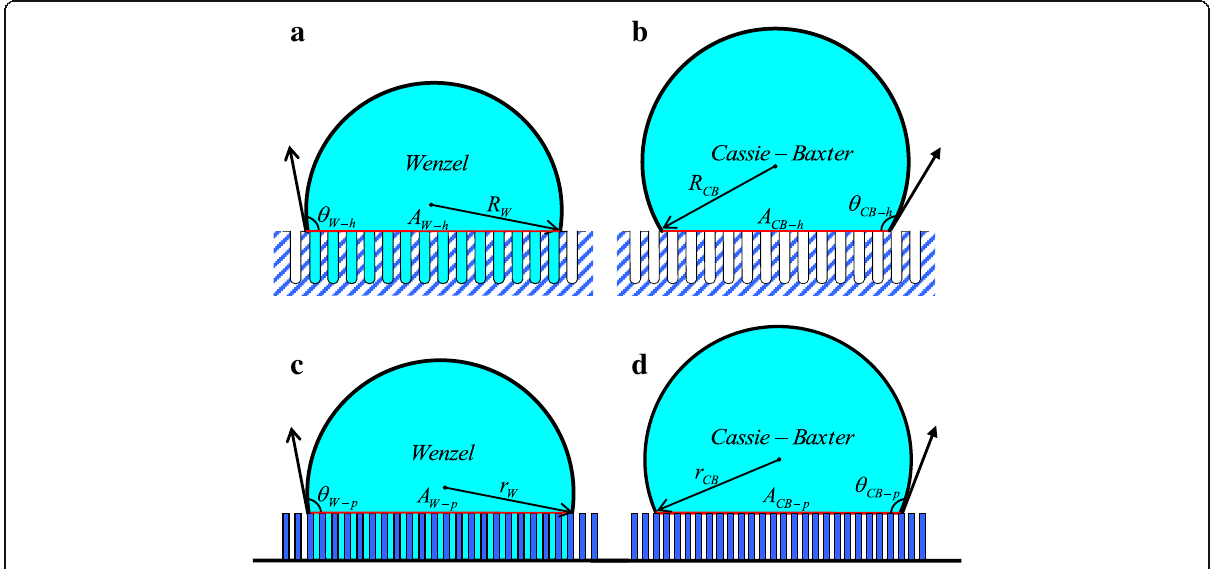
Fig. 2 Schematic illustrations of wetting states of a droplet on a nanohole-patterned surface with the W state ( a ) and the CB state ( b ) and on a nanopillar-patterned surface with the W state ( c ) and the CB state ( d